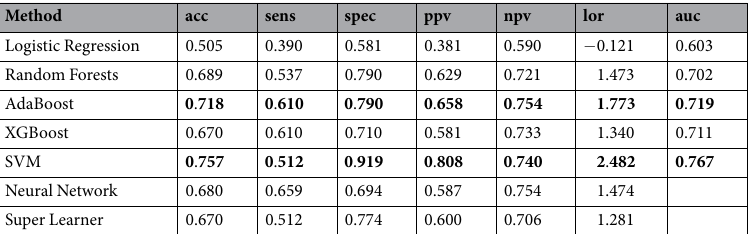
Table 12. Performance of model-based and model-free methods (using all